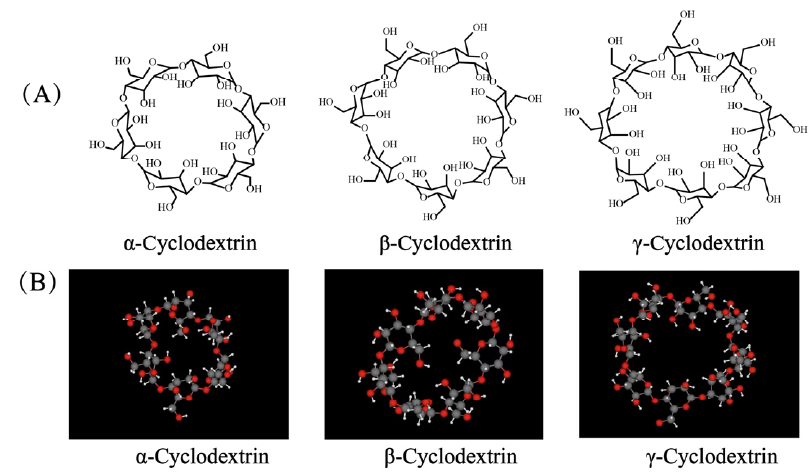
Figure 3. Structures of three common cyclodextrins: ( A ) planar structure; ( B ) 3D structure. Table 2. Cyclodextrin eye drop delivery systems in the application of the anterior and posterior segments of the eye.